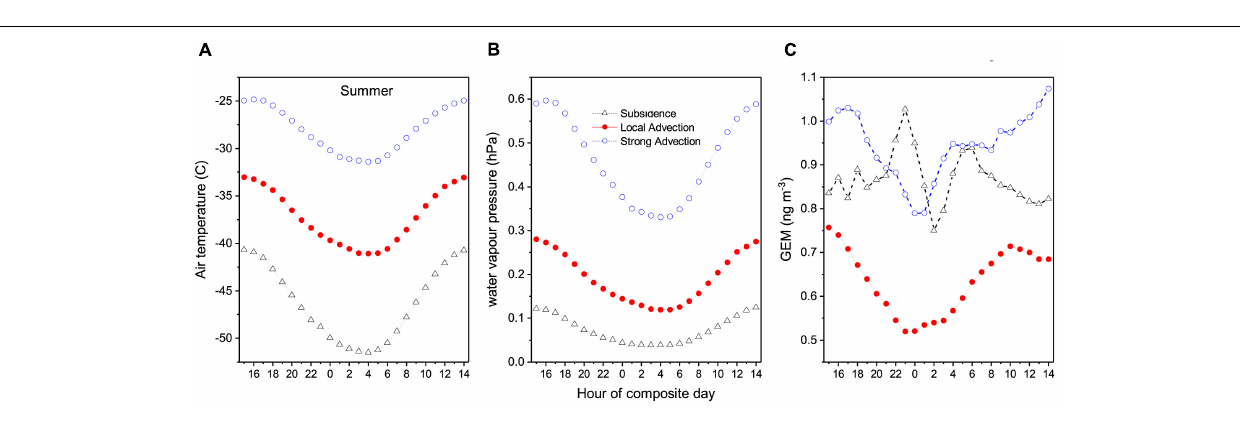
FIGURE 16 | (A–C) Diurnal composite temperature, water vapor pressure, and GEM in summer for the three fetch categories in